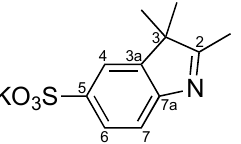
Figure 1. Structure of indolenine 1 .